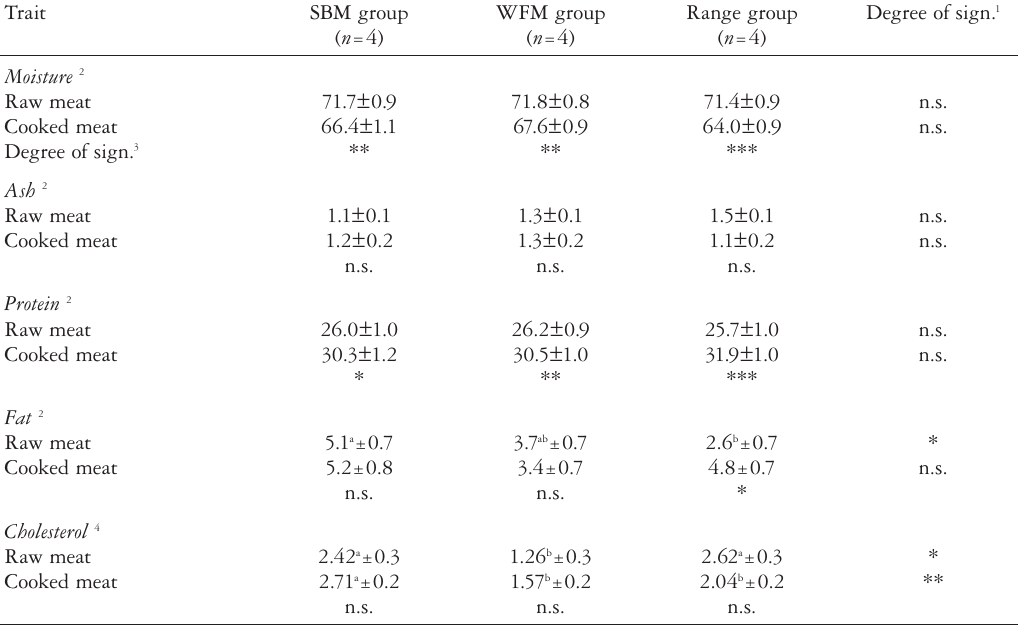
Table 6. Chemical composition of raw and cooked M. longissimus (LD) in reindeer from three different feeding treatments; SBM (feed mixture based on soybean meal protein), WFM (feed mixture based on fish meal protein) and grazing free ranging animals included in the study (least-squares means and standard